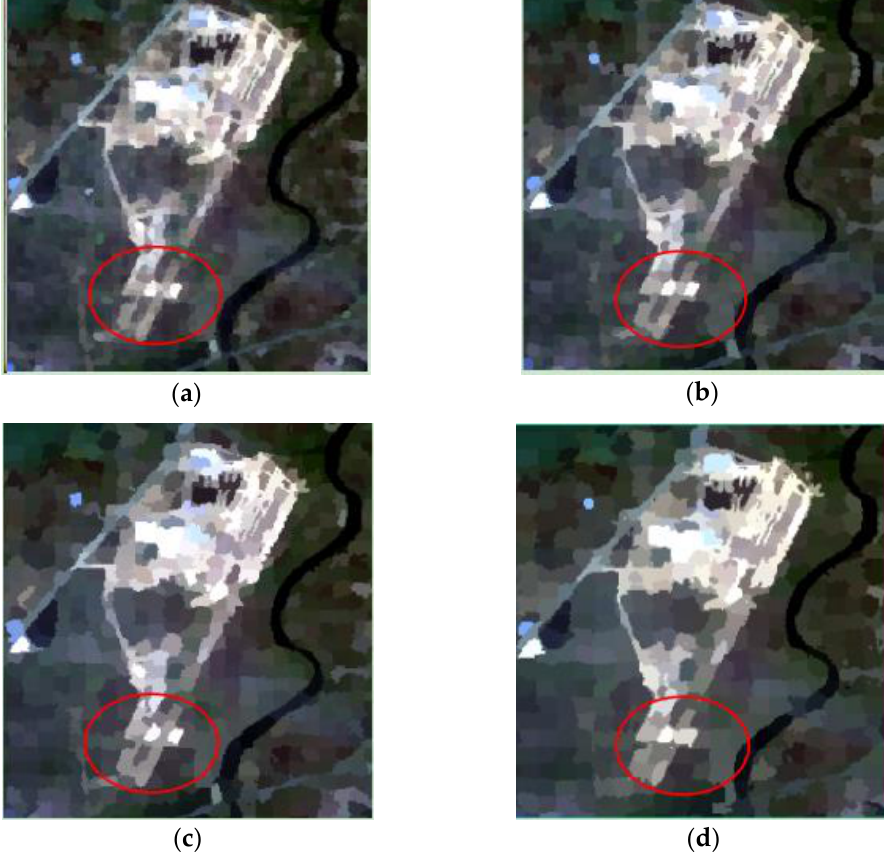
( d ) Figure 10. Results of different segmentation steps for Landsat satellite imagery: ( a ) S = 5; ( b ) S = 7; ( c ) S = 9; ( d ) S = 11.